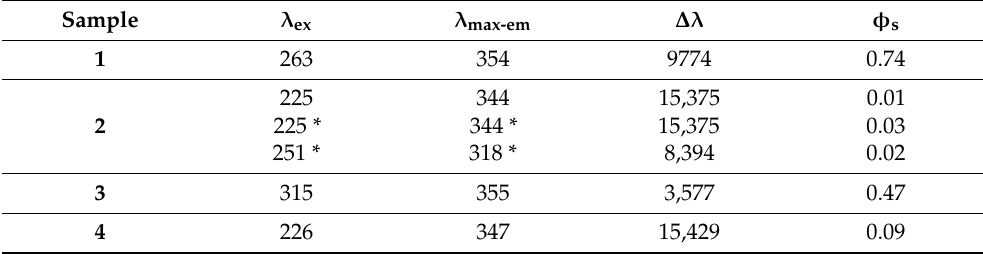
Table 8. UV-Vis and fluorescence data of complexes 1 – 4